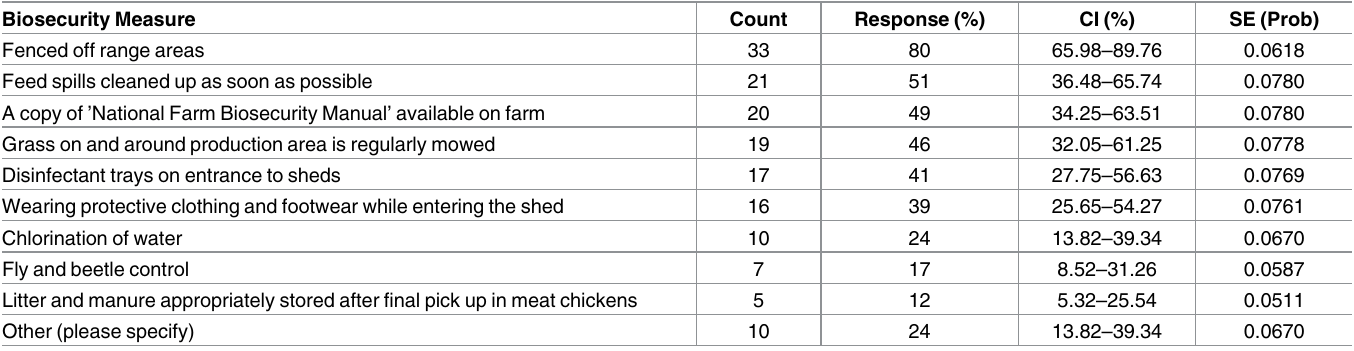
Table 6. Biosecurity measuresas implemented on respondent